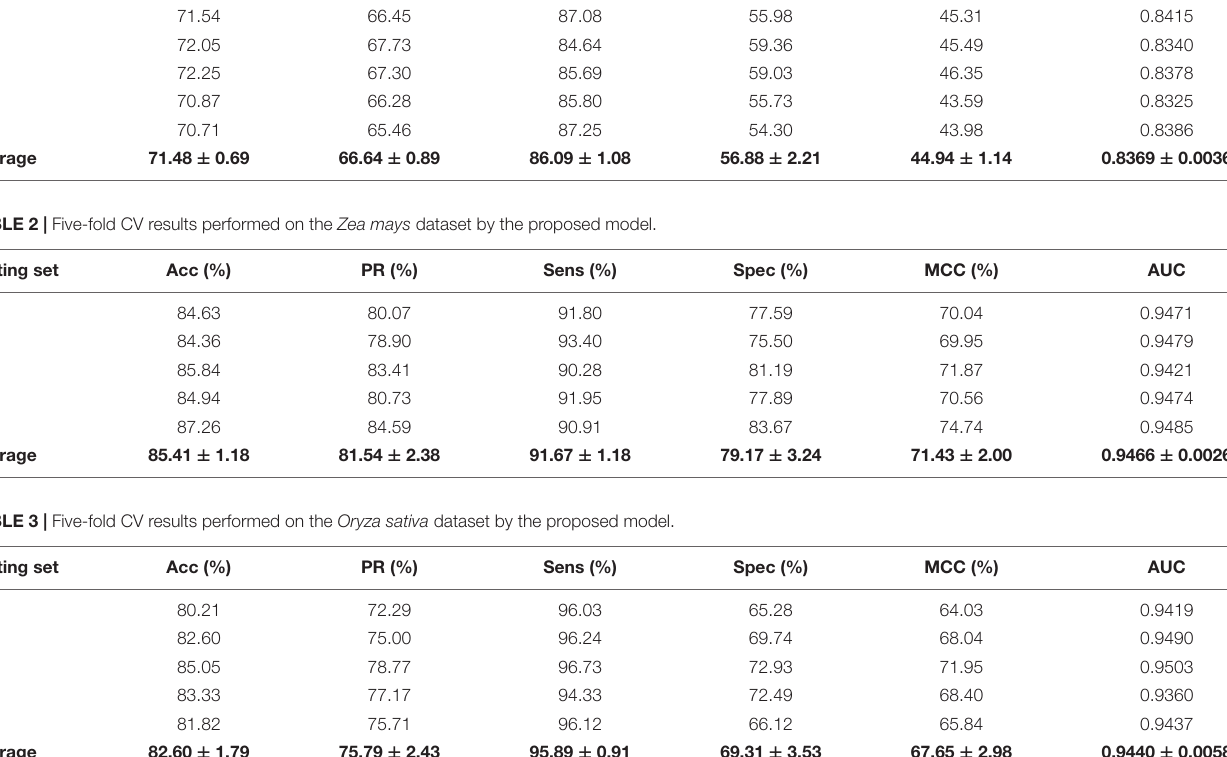
TABLE 1 | Five-fold CV results performed on the A. thaliana dataset by the proposed model. Testing set